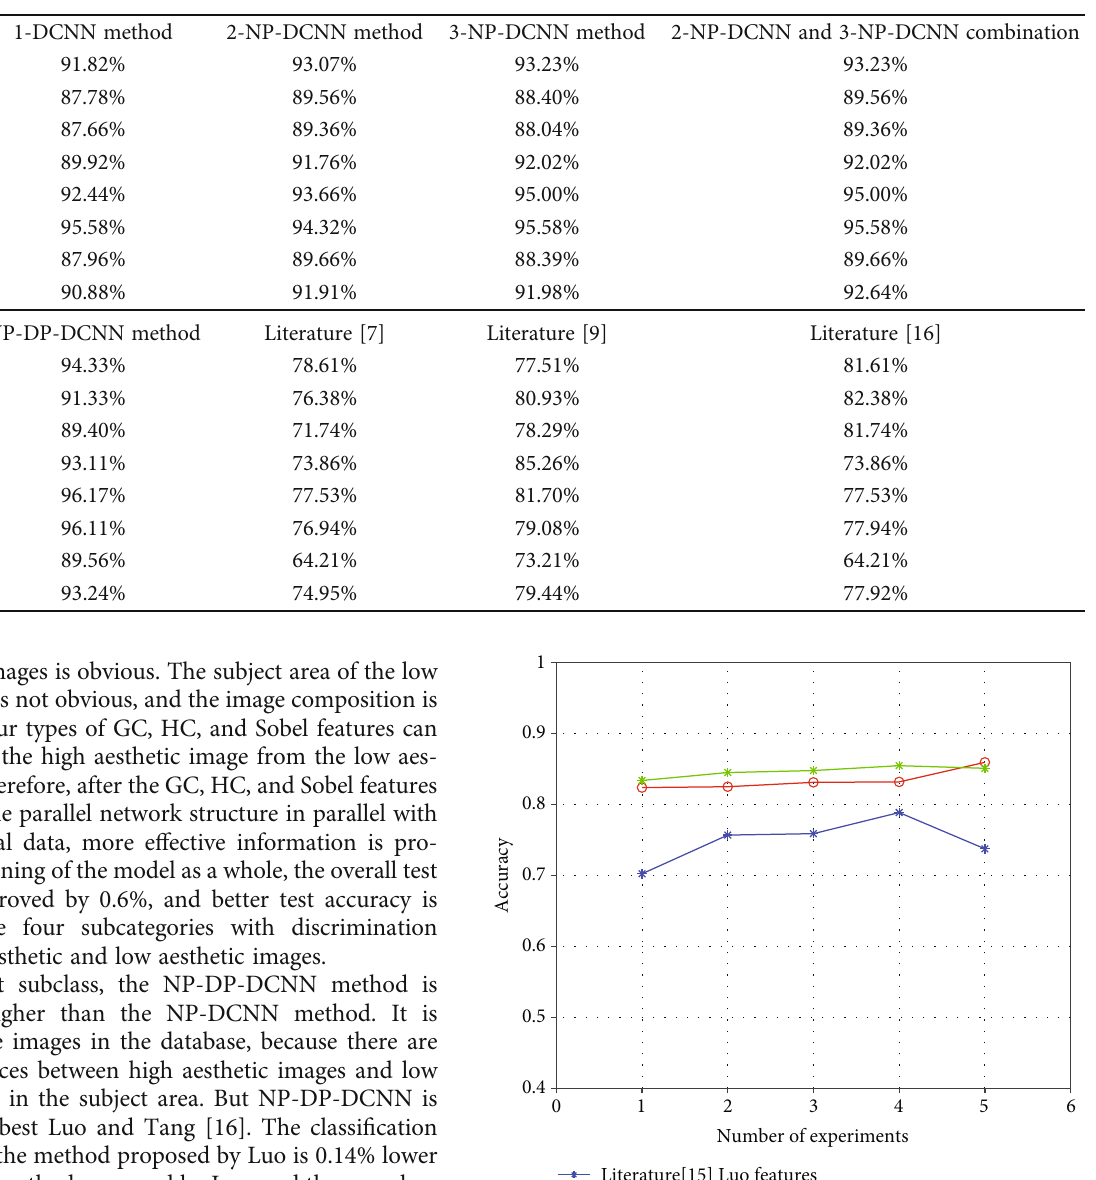
Table 1: Comparison of test accuracy between the NP-DP-DCNN method and other methods in a photoquality dataset database: classi fi cation 1: animal, classi fi cation 2: botany, classi fi cation 3: static state, classi fi cation 4: architecture, classi fi cation 5: scenery, classi fi cation 6: character, and classi fi cation 7: night view.